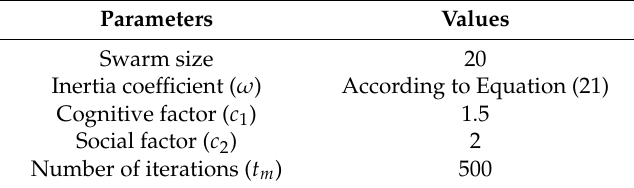
Table 2. PSO parameters.